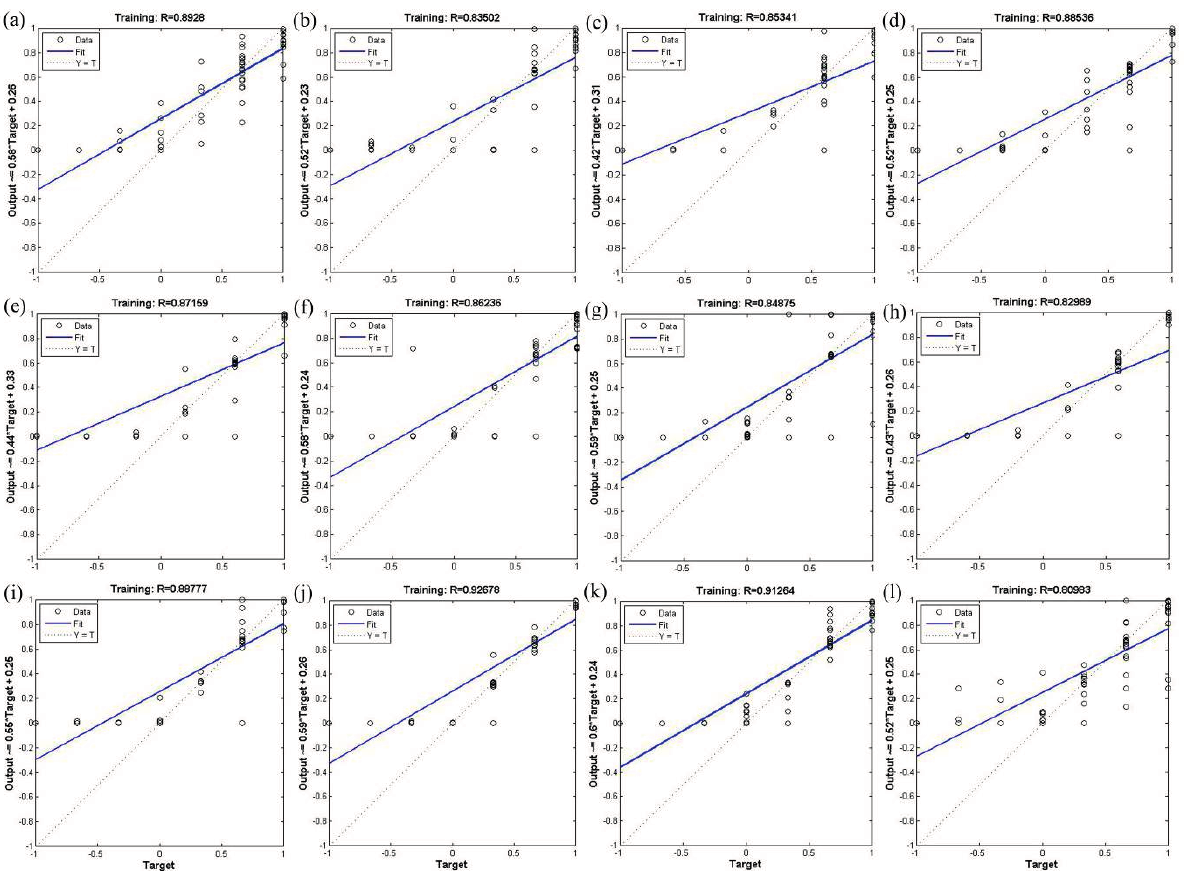
Figure 2. Validation of the BP-ANN model using the trainrp optimization algorithm. The 12 monitoring stations are as follows: ( a ) high-voltage switchgear plant; ( b ) xingqing district; ( c ) the textile city; ( d ) hamlet; ( e ) people’s stadium; ( f ) new district; ( g ) economic development zone; ( h ) chang’an district; ( i ) lintong district; ( j ) qujiang district; ( k ) guangyuntan; ( l ) marsh. The index of agreement (IA) ranged from 0.541 to 0.863 using the trainlm algorithm, and from 0.502 to 0.803 with the trainrp algorithm in the BP-ANN model, which indicates that the predicted values were very close to the observed values. Based on the mean bias error (MBE) values, the model